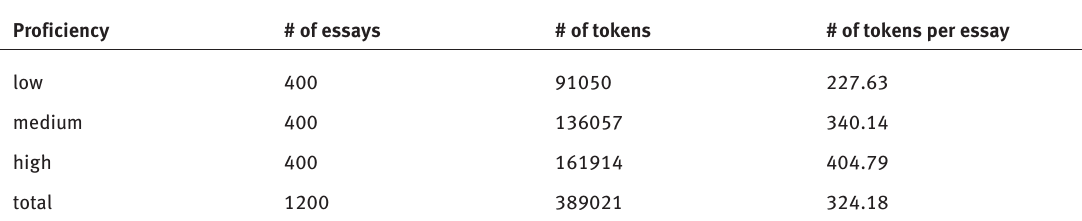
Table 1: Text Samples in Use from ETS Corpus of Non-Native Written English